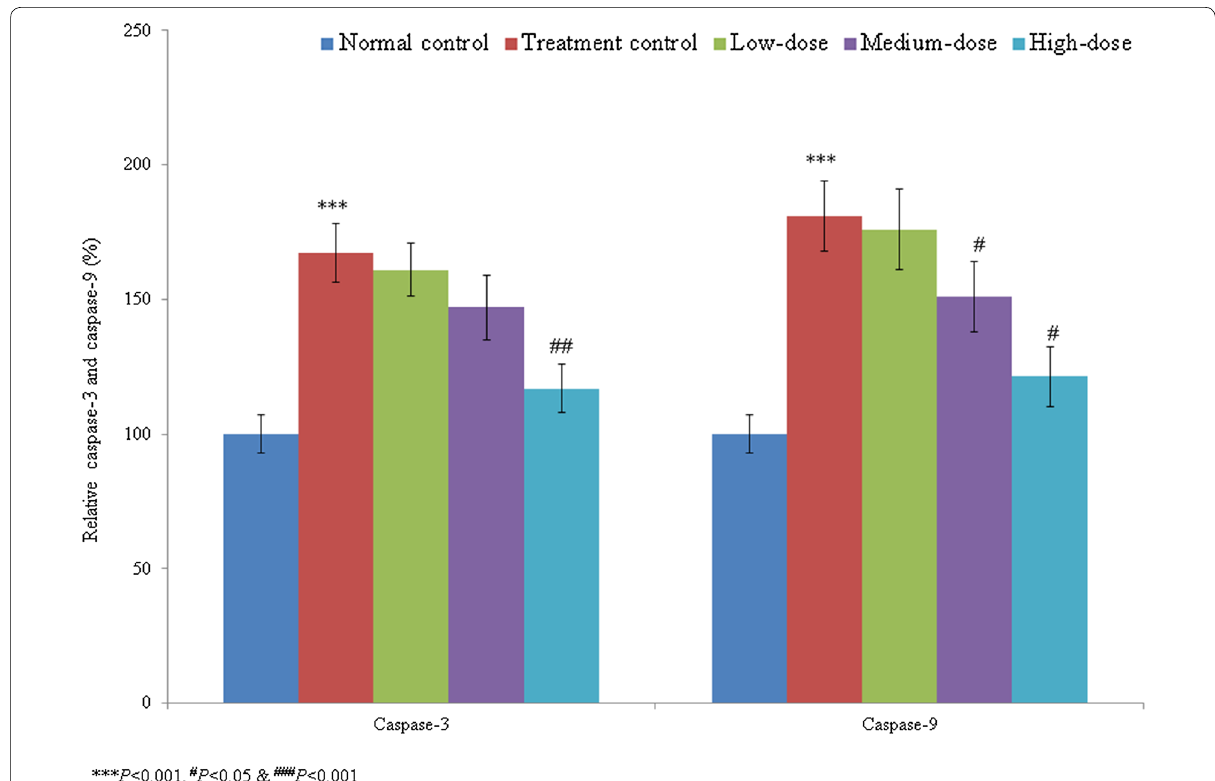
Fig. 4 Effect of catalpol on caspase-3 and caspase-9 activities in human induced pluripotent stem cells with aconitine-induced cardiac arrhythmia. Catalpol treatment significantly reduced the caspase-3 and caspase-9 activities. *** P < 0.001 vs. Group I; # P < 0.05 and ### P < 0.001 vs. Group